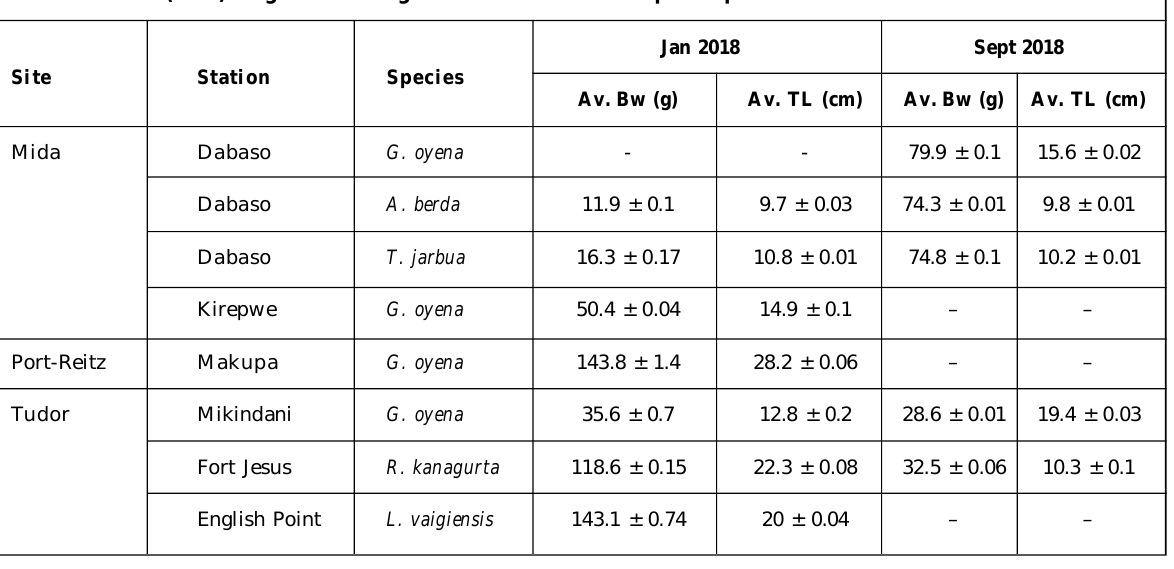
Table 3: Mean (± SE) lengths and weights of fish of different species per site and